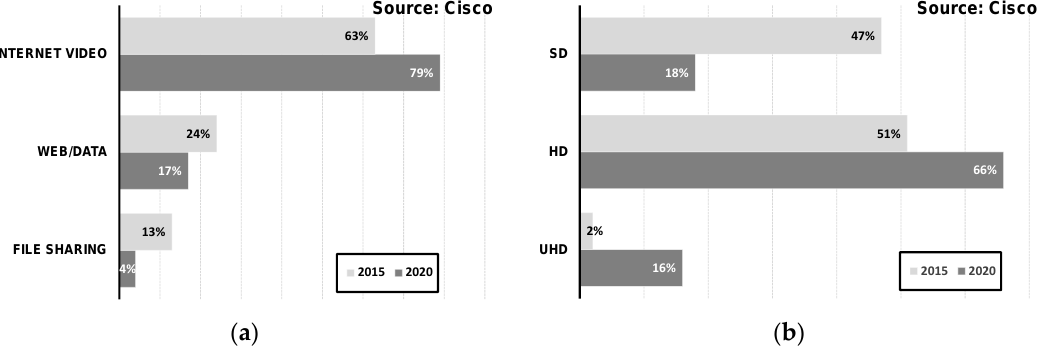
Figure 2. Forecast of global IP traffic ( a ) by application and ( b ) by video content [1].